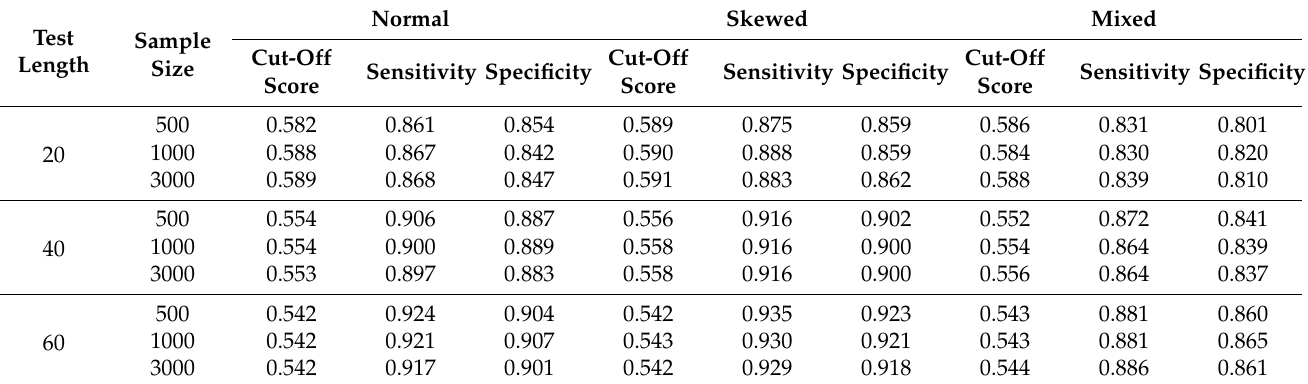
Table 4. Cut-off score with sensitivity and specificity by test length, sample size, and ability